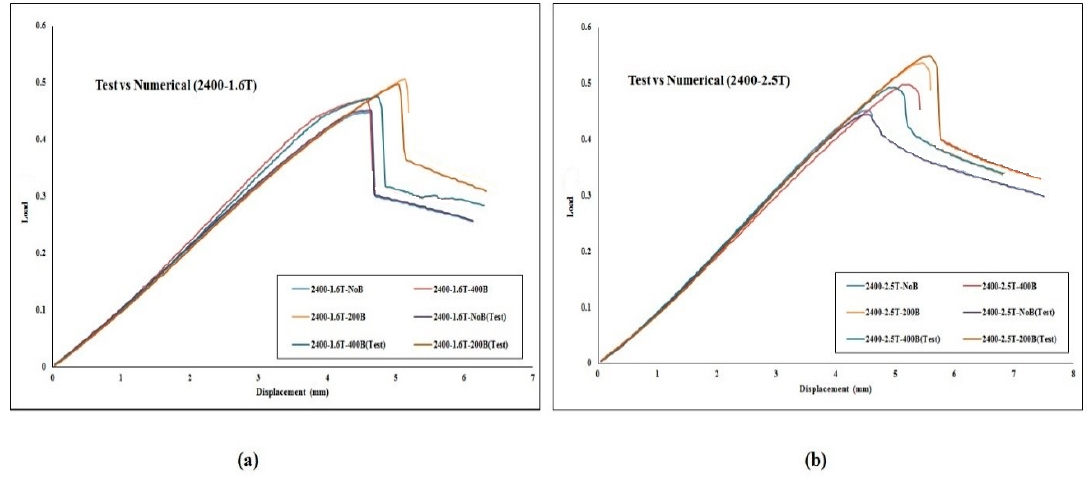
Figure 10. Comparison of experimental and numerical results of normalised load for ( a ) 2400L-1.6T, ( b ) 2400L-2.5T.